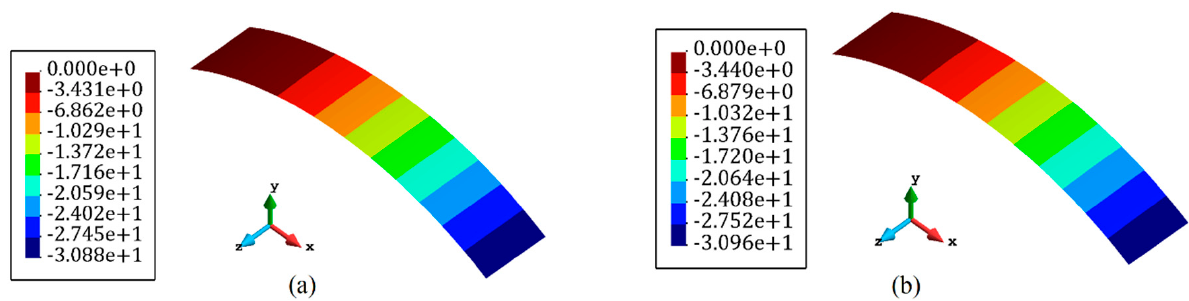
Figure 29. The transverse displacement contour of the curve plate with ( a ) iFEM-GA analysis and ( b ) reference model. ( b ) reference